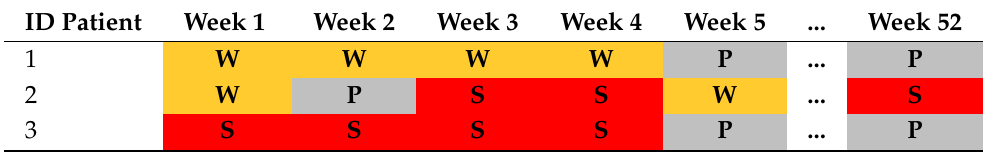
Table 1. Example of State Sequence (STS) format. W (in yellow) and S (in red) stand for weak and strong opioid medication, respectively. P (in gray) stands for pause (no